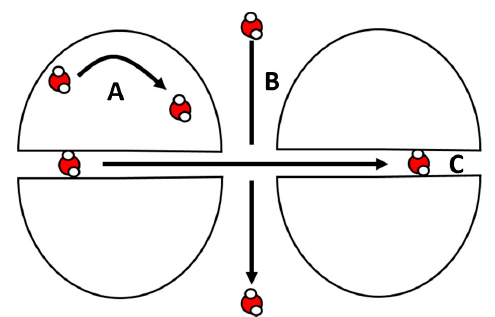
Figure 6. Representation of the three di ff erent motions of H 2 O molecules in quartz sand as inferred by the results of the relaxograms reported in Figure 5. A . Horizontal surface di ff usion. B . Interparticle di ff usion. C . Intraparticle di ff usion.